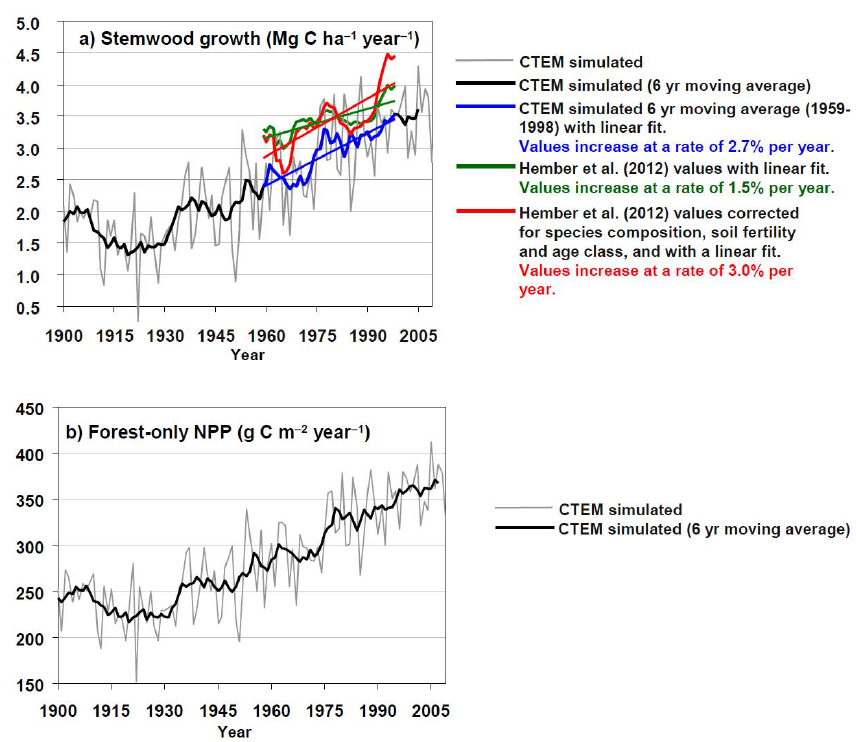
Fig. 7. Comparison of simulated and ground-based observed stem wood growth rate of conifer trees in coastal BC. (a) Observations are based on data collected over the period 1950–2002 as explained in Hember et al. (2012). Model estimates are for all needleleaf evergreen trees exclusively in coastal region of BC. Black and blue lines for simulated results are 6yr moving averages. Linear regression lines are on top of the model estimates and observations during the 40yr period for which observations are available. Panel (b) shows forest-only net primary productivity (NPP) in all forest-covered regions in BC, as well as 6 yr moving average of forest